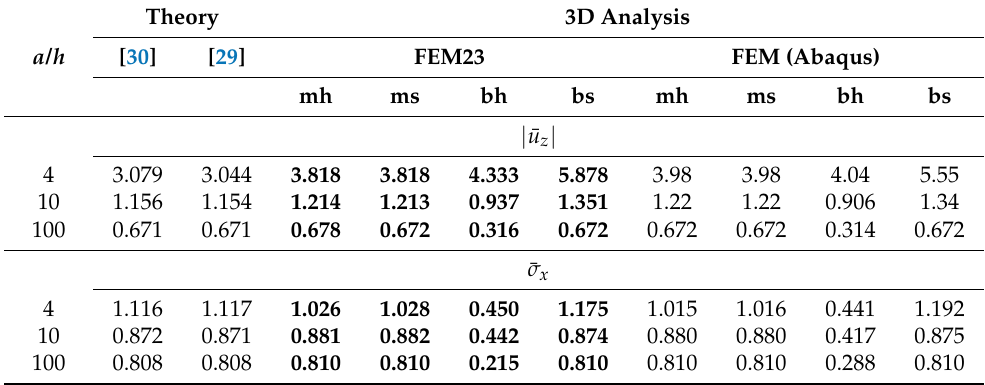
Table 1. Example 1: The results for the simply supported plate.